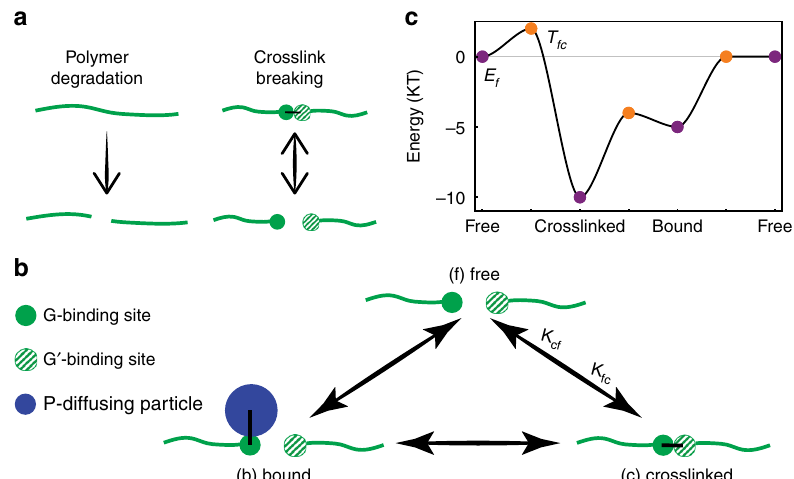
Fig. 2 Model for crosslink dynamics. a Polymer degradation and crosslink breaking are two potential ways for a large particle to escape its cage in a polymer gel. However, crosslink breaking is reversible while polymer degradation is not. Therefore, our mechanism focuses on controlling the crosslink dynamics. b The G crosslink binding sites (solid green circles) can be in one of three states: free, where it is not bound to anything; crosslinked, where it is bound to a complementary G ′ crosslinking site (striped green circles); and bound, where it is bound to a binding particle (blue circle). Arrows show the transitions between the states, the dynamics of which are controlled by the three state energies ( E f , E c , and E b , respectively), and the three transition state energies ( T fc , T cb , and T bf ). Without loss of generality, we set E f = 0, but the remaining fi ve energies are free parameters in our model. The transition rates (e.g., k fc , the rate of transitioning from the free to crosslinked states) are given by the energies according to (4). Note that transition state energies must be greater than or equal to both neighboring state energies. c Plot of arbitrarily chosen state energies (purple) and transition state energies (orange). Since the reactions shown in b form a single closed loop, the reaction coordinate in c is periodic, as indicated by the repetition of the free